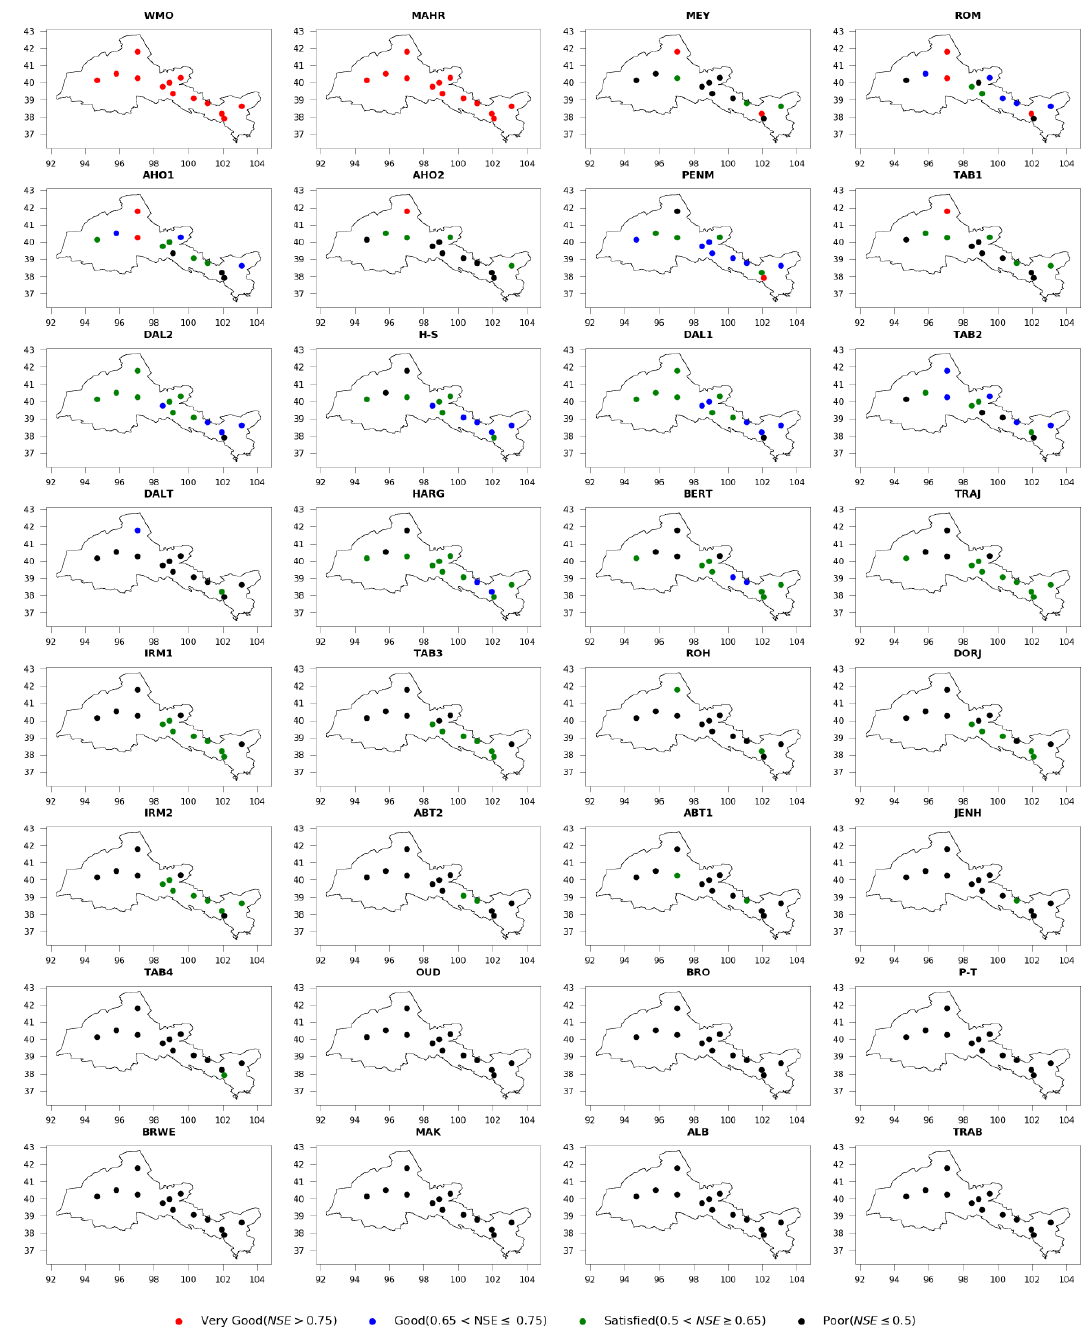
Figure 4. Spatial distribution of daily Nash–Sutcliffe efficient ( NSE ) values computed from the 32 simple ET 0 models in reference of the PM-FAO56 method over the Hexi corridor region (Full names of each model are shown in Table 2).